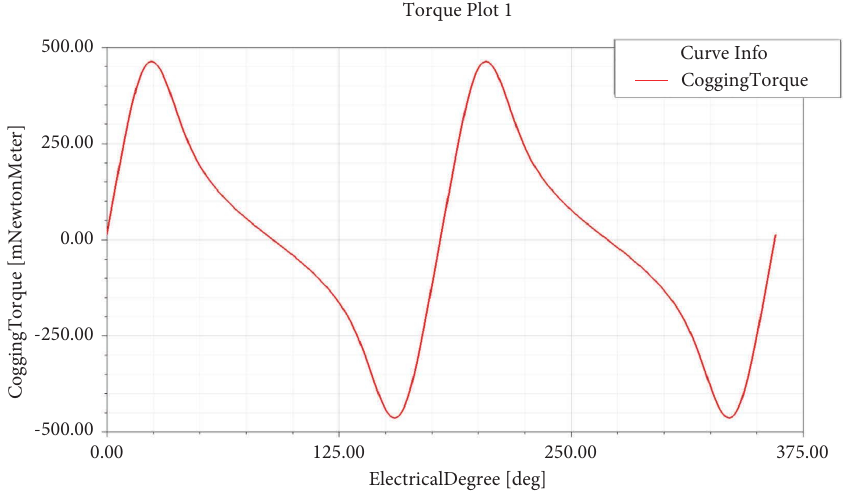
Figure 25: Cogging torque of pear-shaped circular slot motor.